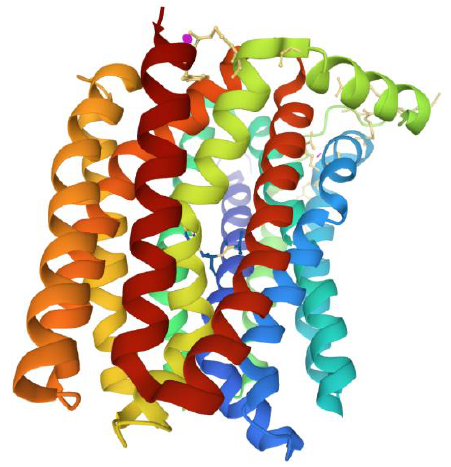
Figure 7. Crystal structure of E. coli MdfA multidrug efflux pump from the MFS. The MdfA trans- porter is complexed to one of its substrates, chloramphenicol (ball and stick structure). Ribbons of different colors represent the transmembrane helices. The loops between the transmembrane domains were removed for clarity. The model of the MdfA structure was generated using NGL Viewer [106] from the Protein Database, PDB [107], entry 4ZOW from Heng et al. [130].